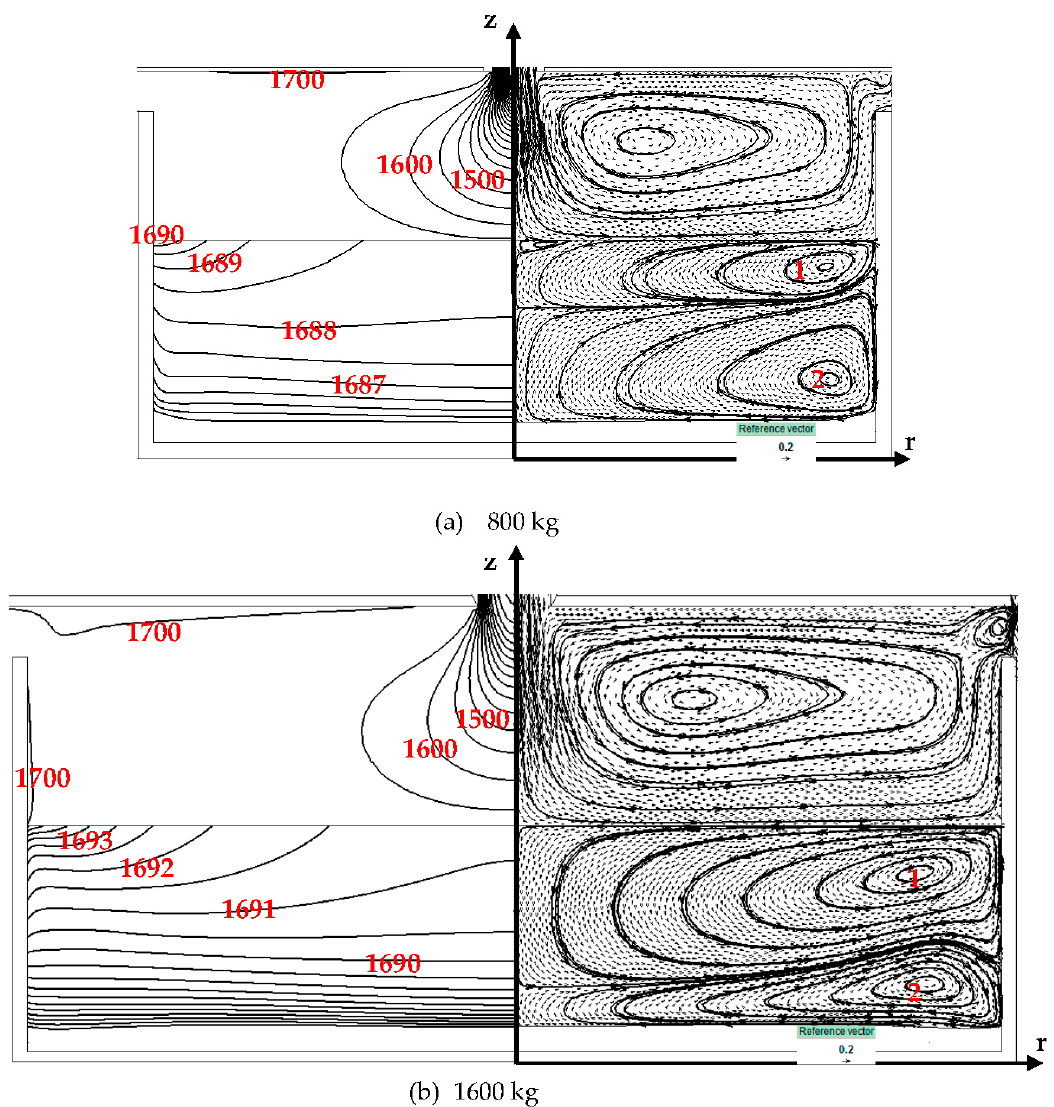
Figure 1. Distribution of temperature ( left , ∆ T = 0.5 K (in melt), ∆ T = 50 K (in gas)) and flow structure ( right ) in the silicon melt and argon gas at a solidification fraction of 10% with different silicon feedstock capacities: ( a ) 800 kg; ( b ) 1600 kg.